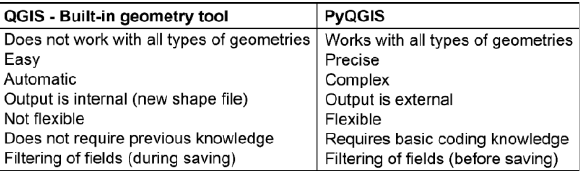
Table 2. Comparison of built-in geometry tools and PyQGIS coding console. Advantages and disadvantages in terms of data extraction, coordinates’ addition, and filtering (source: